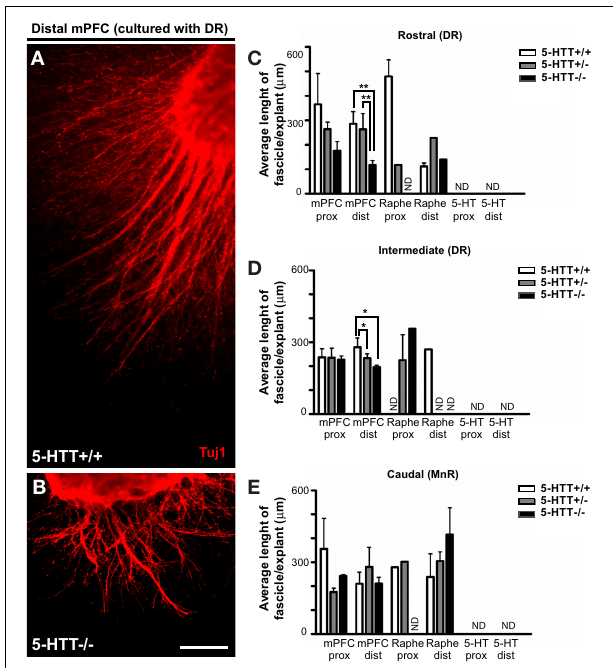
FIGURE 4 | Differences in length of fascicles from the mPFC controlled by the presence of 5-HTT during development. (A,B) Example of differences in fascicle length in the distal quadrant of 5-HTT + / + and 5-HTT − / − mPFC co-cultured with the rostral subarea. Scale bar represents 100 μ m. (C–E) Quantification of the length of fascicles in the proximal and distal quadrants of a subarea cocultured with mPFC. Graphs show average length of fascicles per explant ± SEM. One-Way ANOVA ( α = 0 . 05), ∗ p < 0 . 05, ∗∗ p < 0 .